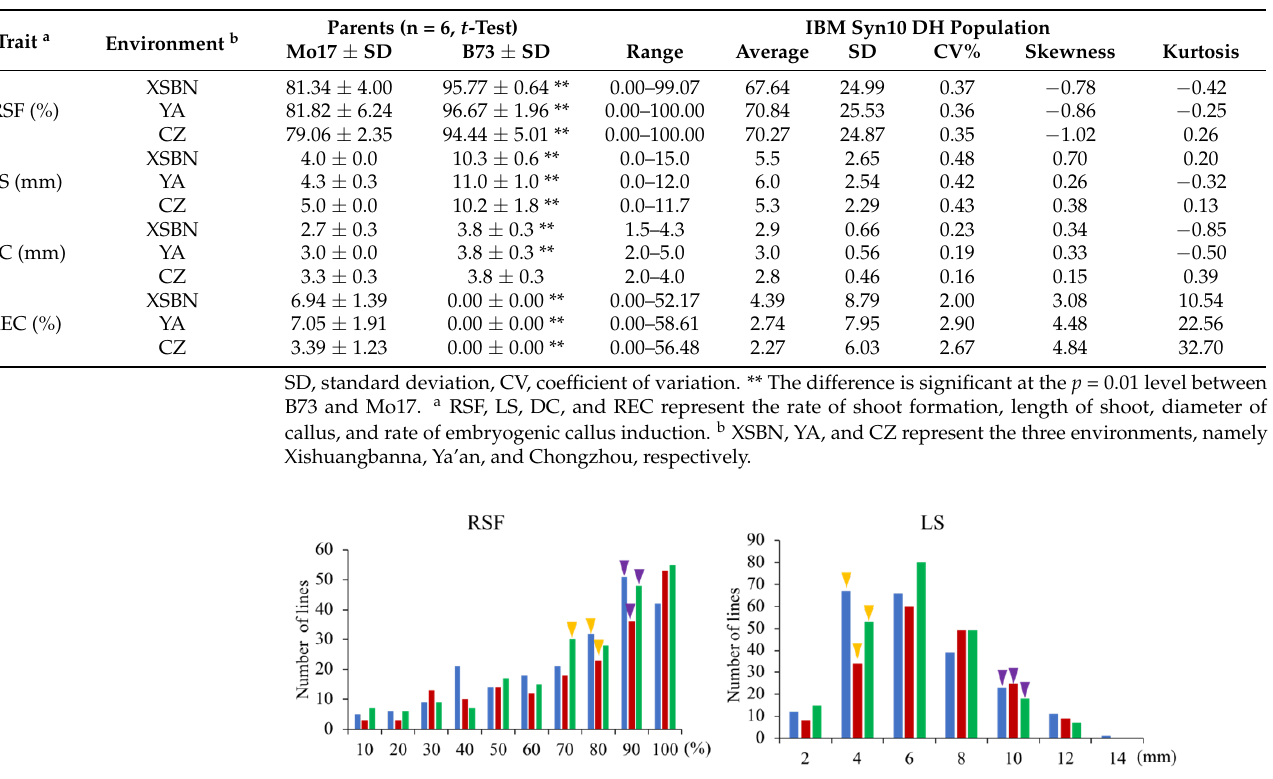
traits were all smaller than 1 except for the RSF in the CZ environment, verifying that the RSF, LS, and DC generally conformed to normal distributions and were typical quantitative Table 1. Phenotypic performances of four traits in the IBM Syn10 DH population and its parents. Trait a Environment b